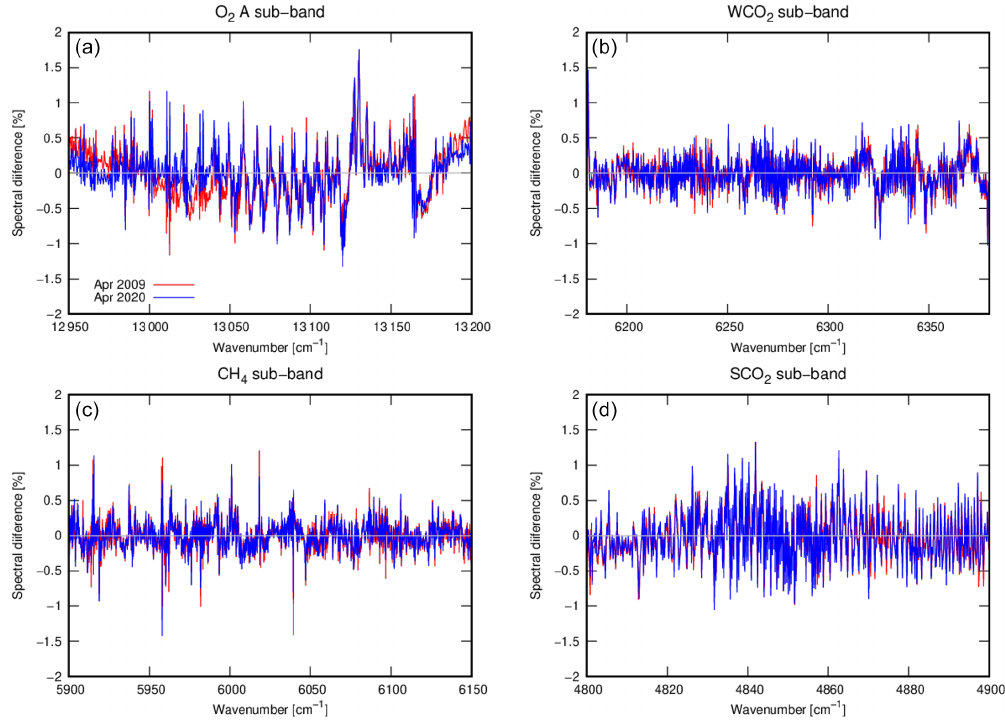
Figure 1. Averaged spectral residuals (simulated minus observed) normalized with the maximum radiance in each range at O 2 A (a) , WCO 2